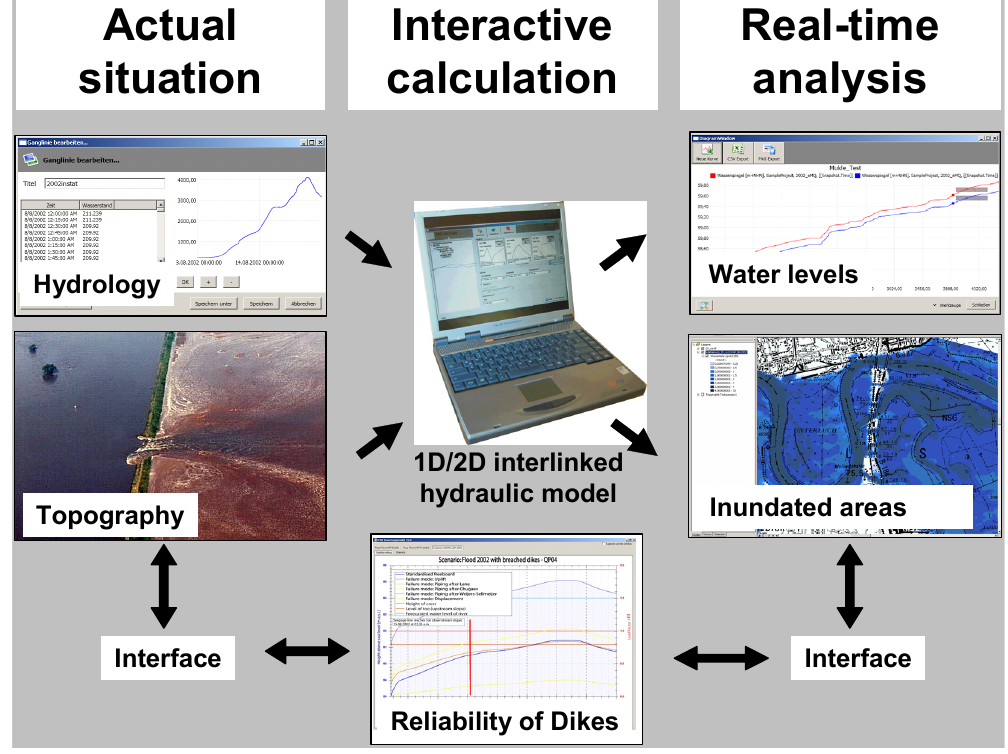
Fig. 5. Principle scheme for real-time